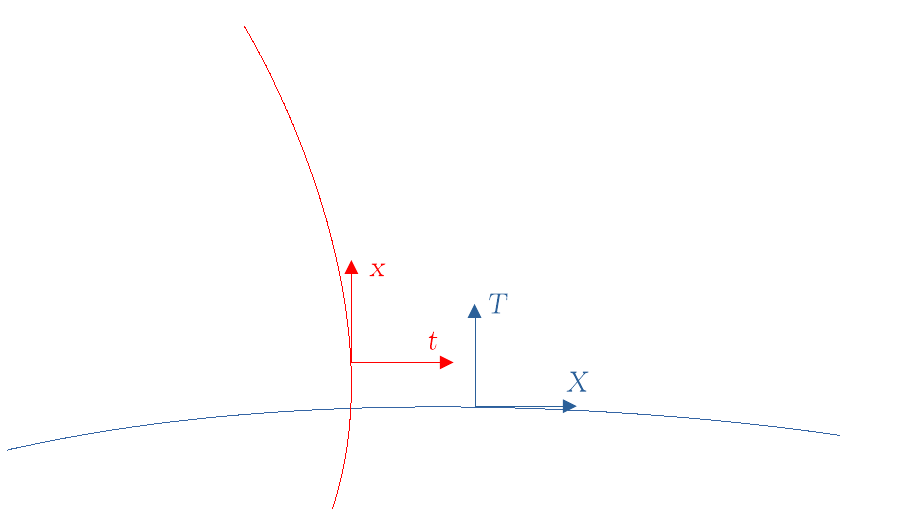
Figure 4. A homogeneous time-like slicing with coordinates ( t , x ) and an inhomogeneous space-like slicing with coordinates ( T , X ) , both in the same static spherically symmetric